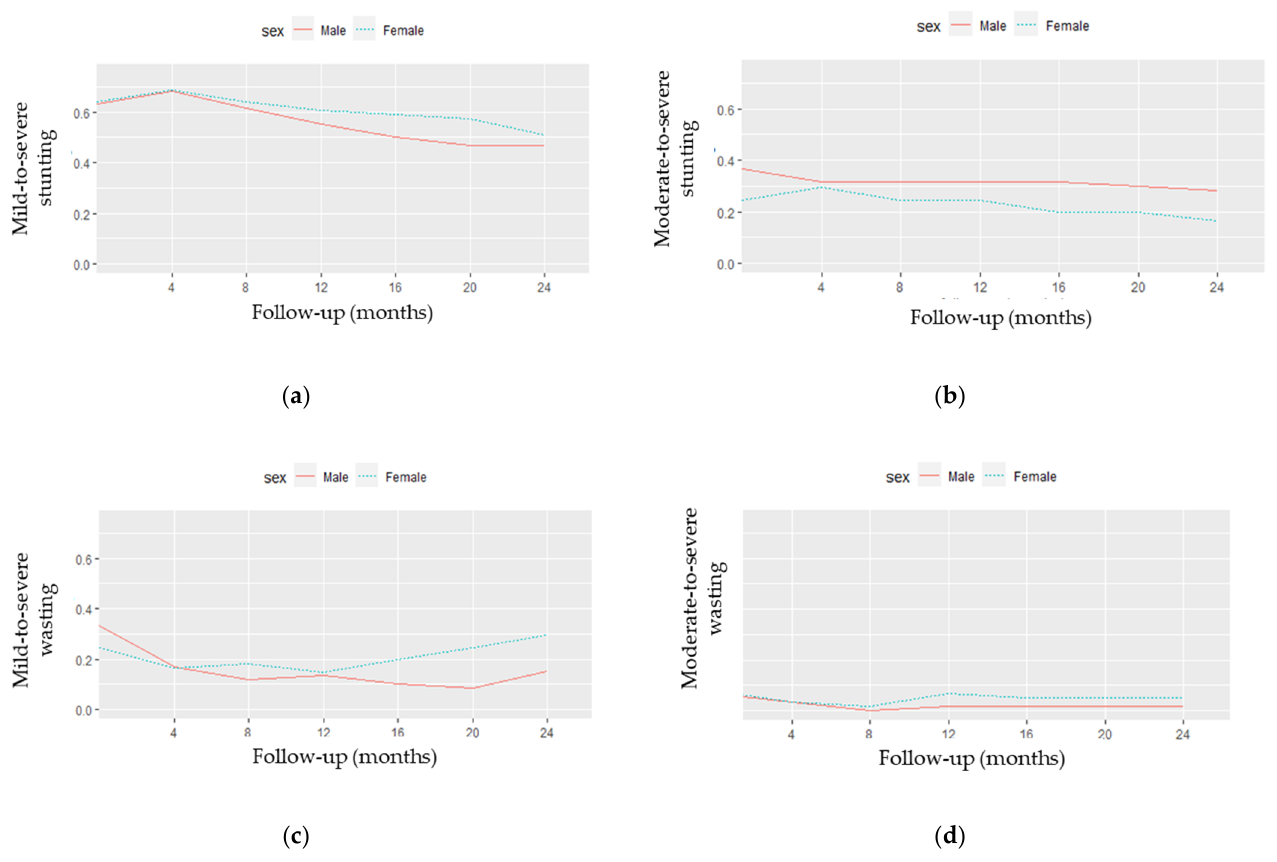
Figure 5. Observed stunting and wasting profiles by sex: ( a ) mild-to-severe stunting; ( b ) moderate- to-severe stunting; ( c ) mild-to-severe wasting; ( d ) moderate-to-severe